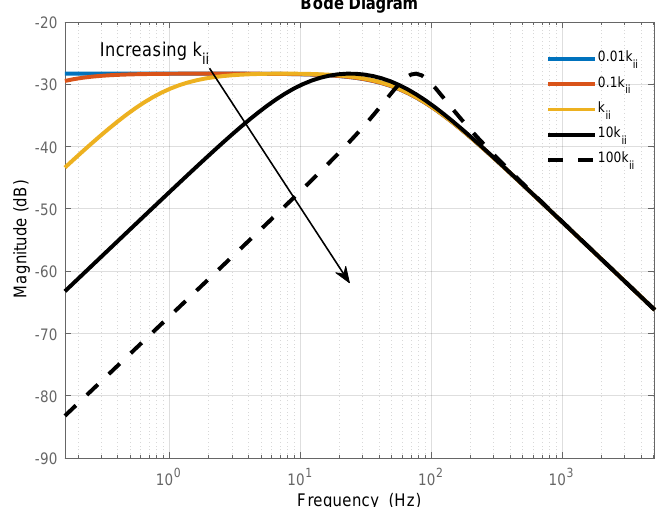
Figure 13. Sensitivity of Output Admittance Y oc , i ( s ) to k ii in increasing order of 0.01 × , 0.1 × , 1 × , 10 × , and 10 × k ii (base case).